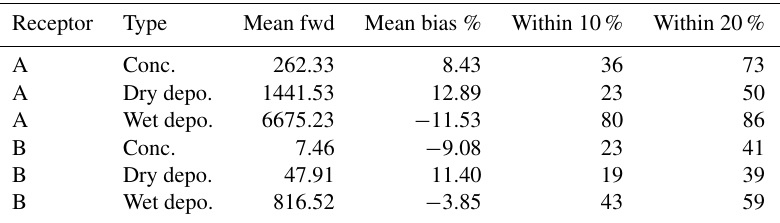
Figure 7. Emission sensitivities and emission contributions for point B integrated over the period 8–10 March 2012. (a) shows time series of backward modelled dry (green line) and wet deposition (blue line) for point B. In (b, c) , the integrated emission sensitivity (ES) (in mm) and emission contribution (EC) (unit of ngm − 2 per grid cell) at the receptor are shown for dry deposition averaged over the 2 days sampling period marked with grey background shading in (a) . The emission contribution is obtained by multiplying the emission sensitivity (in mm) with emission fluxes given in units of ngm − 3 s − 1 (from Fig. 3a) resulting in a unit of ngm − 2 s − 1 for the time-average deposition flux. The deposition flux multiplied with the sampling interval gives the total mass deposited over the receptor in units of ngm − 2 . (d, e) The same as (b, c) , but for wet deposition. Table 3. Statistical comparison of forward and backward simulations for concentrations, dry deposition and wet deposition values, for receptor points A and B. Reported are the mean values for Mar 2012 for the forward simulation, the mean relative bias between backward and forward simulations (%), and the percentage of all values (out of 248 in total) of the backward simulation with less than 10% (20%) deviation from the forward